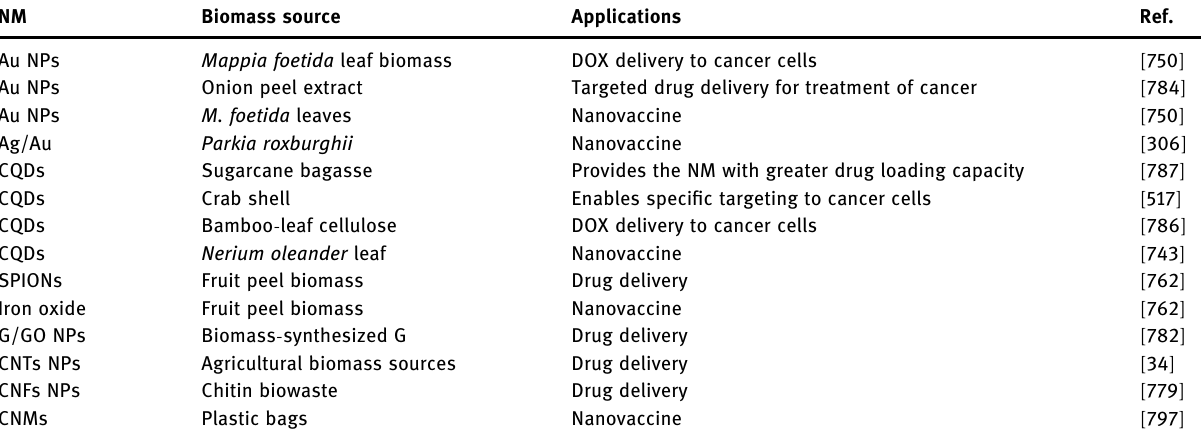
Table 17: Application of recycled NPs as nanodrugs and nanovaccines NM Biomass